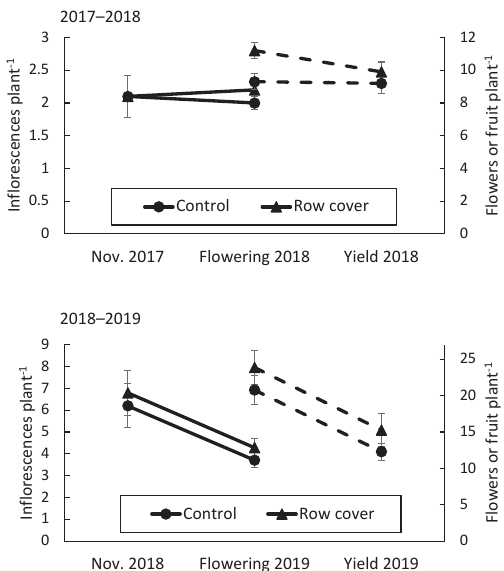
Fig. 6. Number of inflorescences (solid line) observed through flower mapping (development stages 5 or higher) on 6 November 2017 and 2018 and during flowering, and the number of flowers and fruit (dotted line) in strawberry cv. Wendy with fall row cover installed on 28 August 2017 for 2017–2018, and 12 September 2018 for 2018– 2019, or uncovered (control). Vertical bars represent ± SEM, n =